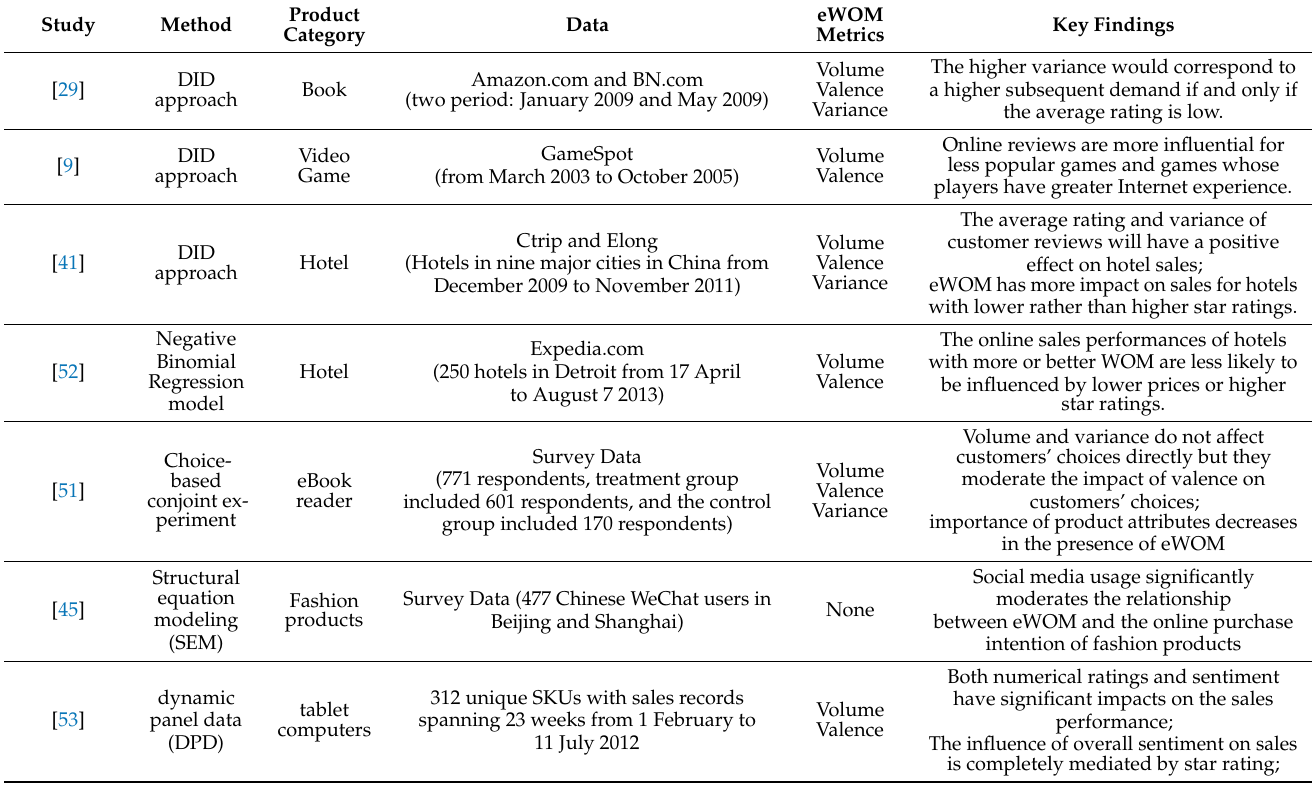
Table 2. Studies about the joint effect on